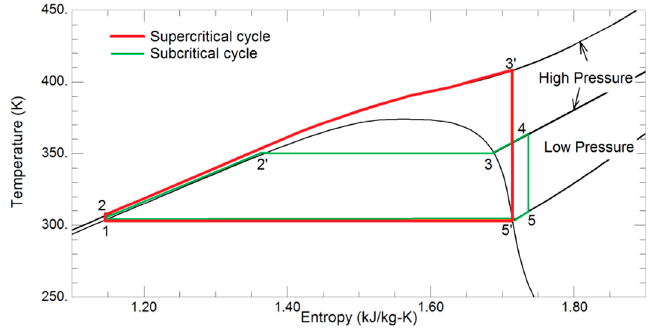
Figure 1. Typical subcritical and supercritical cycles in temperature-entropy diagram.